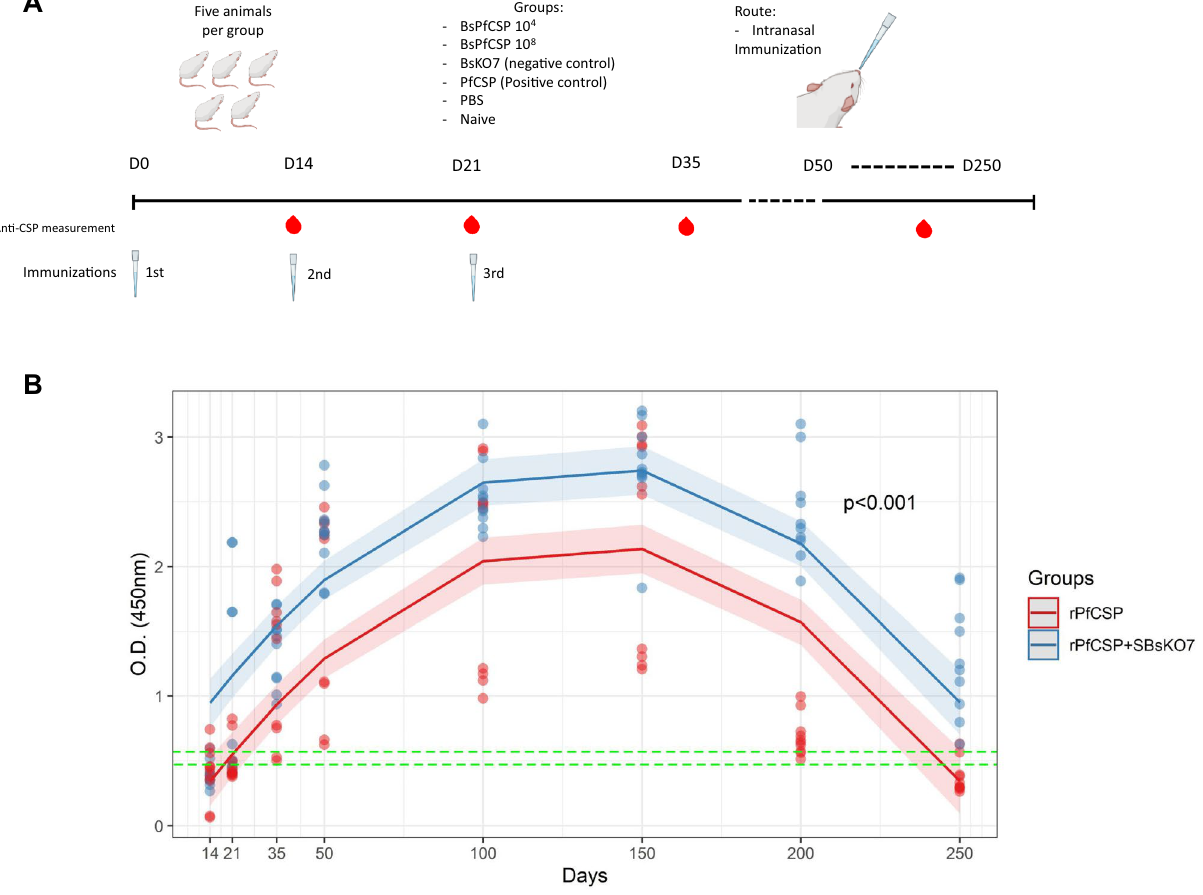
Figure 2. Indirect ELISA quantification of total IgG in mice. ( A ) Schematic showing the nasal immunization regimen and the follow-up period of the humoral immune response in mice. ( B ) Graph showing indirect ELISA quantification of total IgG from mice immunized intranasally with r Pf CSP and r Pf CSP coupled to S Bs KO7 (O.D 450 nm) at each blood sample collection day. The horizontal green lines correspond to the cutoff, which was calculated with the negative controls mean (non-immunized, 1 × 10 8 S Bs KO7, and PBS mice groups) plus two/three times of its standard deviation. The blue line corresponds to the mean O.D. (450 nm) of the group of mice immunized with r Pf CSP + S Bs KO7 for each collection day (D14, D21, D35, D50, D100, D150, D200, and D250) and each blue dot represents the mean of O.D. of a mouse from the group in duplicate. While the red line corresponds to the mean O.D of the group of mice immunized only with r Pf CSP and each red dot corresponds to the mean O.D. of ELISA reactivity of a mouse blood sample. It is observed that the confidence bands do not touch each other at any time in the curves for each group, thus demonstrating that the r Pf CSP + S Bs KO7 group has the highest mean O.D. on all days of the experiment with a significant value of p < 0.001. The significance level considered was p <